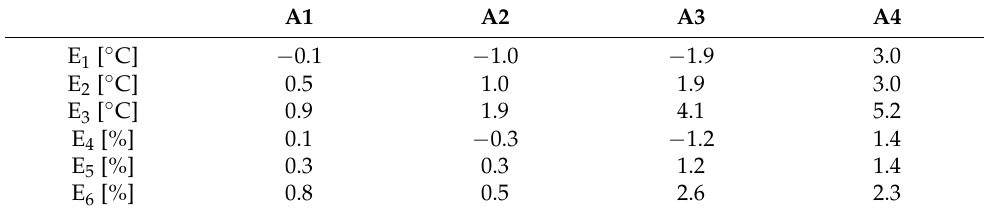
Table 8. Values of estimates E 1 –E 6 for temperatures (14)–(19), with heating process p4, in planes Table 15. Values of estimates E 1 –E 6 for HTC (20)–(25) with heating process p4 in planes A1–A4.